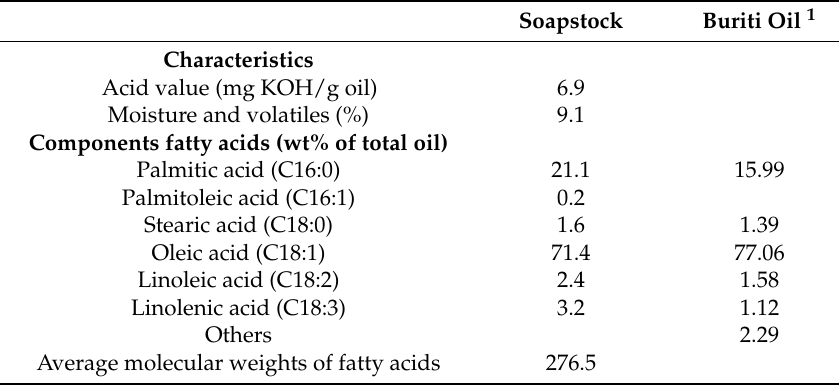
Table 1. Main characteristics of the buriti soapstock oil and buriti oil.